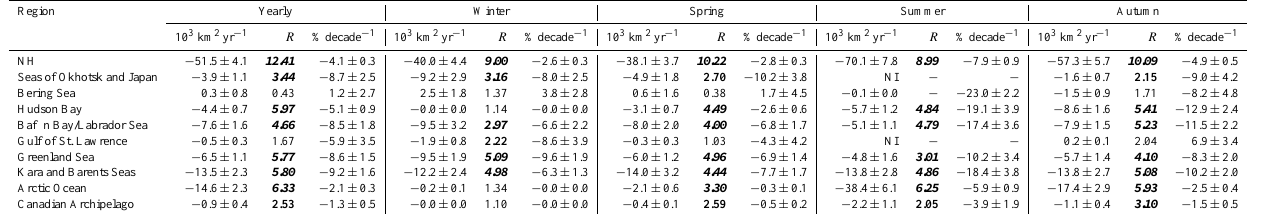
Table 1. Yearly and seasonal Arctic sea ice extent trends for the period 1979–2010 with estimated standard deviations * . Region Yearly Spring